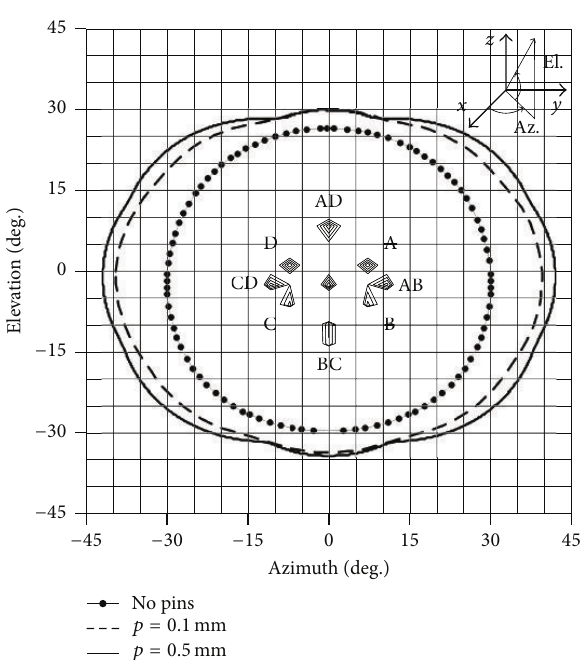
Figure 2: Antenna radiation pattern level graph for different con- figurations of shorting pins at 60 GHz. In the center of the graph normalized radiation patterns are shown for 𝑝 = 0.5 mm with minimum level − 0.02 dB. Outer graphs show realized gain level of radiation pattern for the reference antenna (no pins) and for the reconfigurableantennatotalscanpatternswhenallpossibleshorting pins configurations are applied. Realized gain levels correspond to − 3 dB from the reference antenna maximum realized gain.